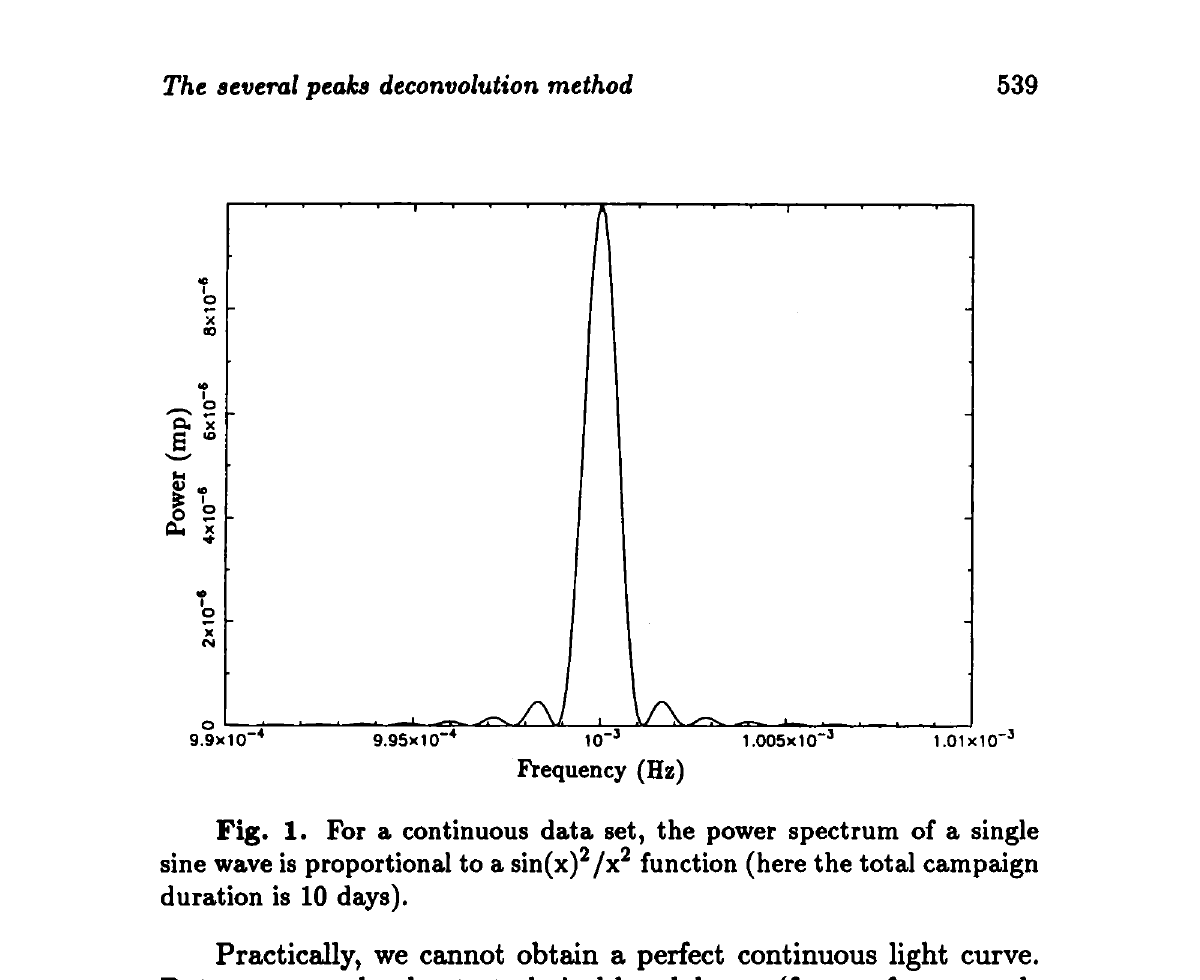
Fig. 1. For a continuous data set, the power spectrum of a single sine wave is proportional to a sin(x) 2 /x 2 function (here the total campaign duration is 10